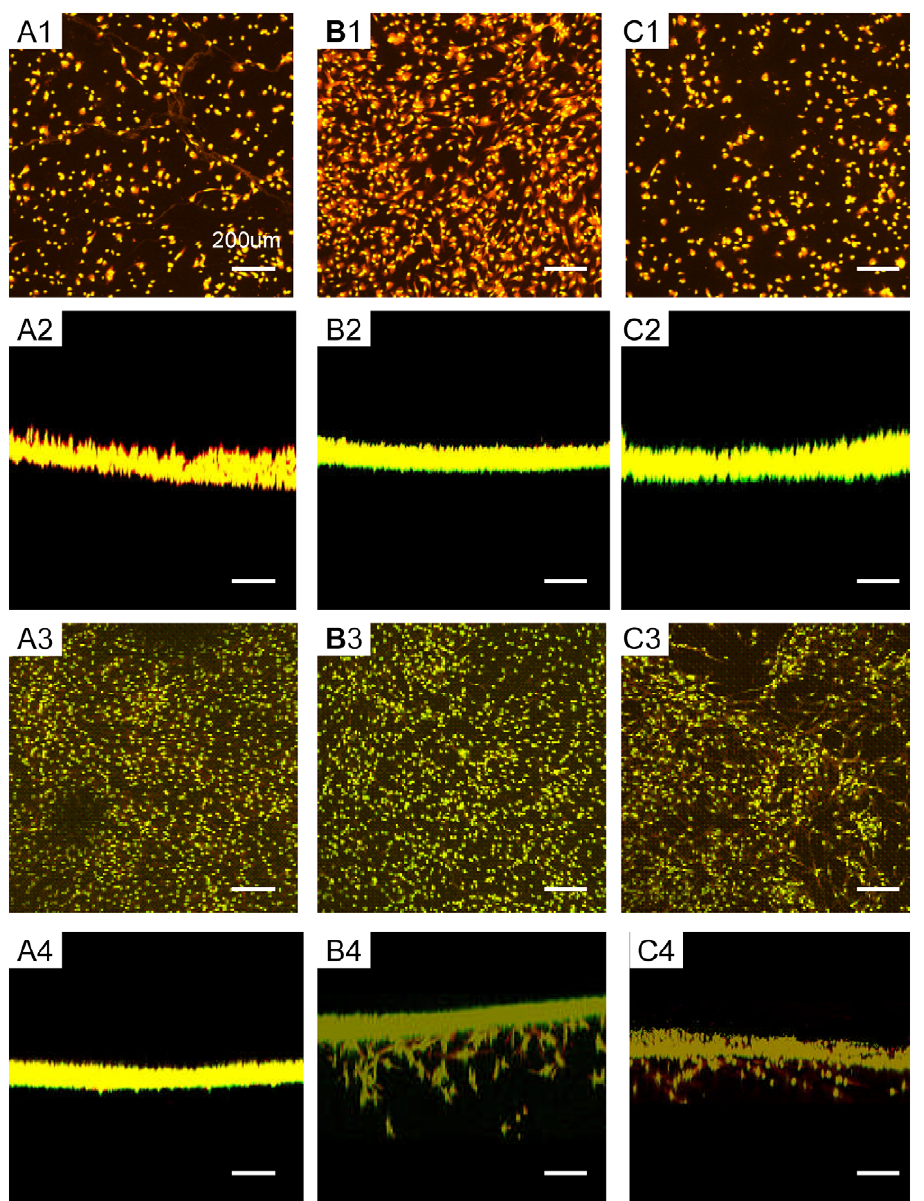
Figure 4. Constructed images of 3-D confocal microscopy images of periodontal ligament fibroblasts on the different scaffolds. Fluorescent staining with Rhodamin phalloidin and SYTOX Green. A) RADA16, B) PRG and C) PDS. A1, B1,C1) Vertical and A2, B2,C2) horizontal images after five hours culture. A3, B3, C3) Vertical and A4, B4, C4) horizontal images after two weeks culture. There were significant cell migrations into the functionalized peptide scaffolds PRG and PDS after two weeks. The scale bar represents 200 um for all